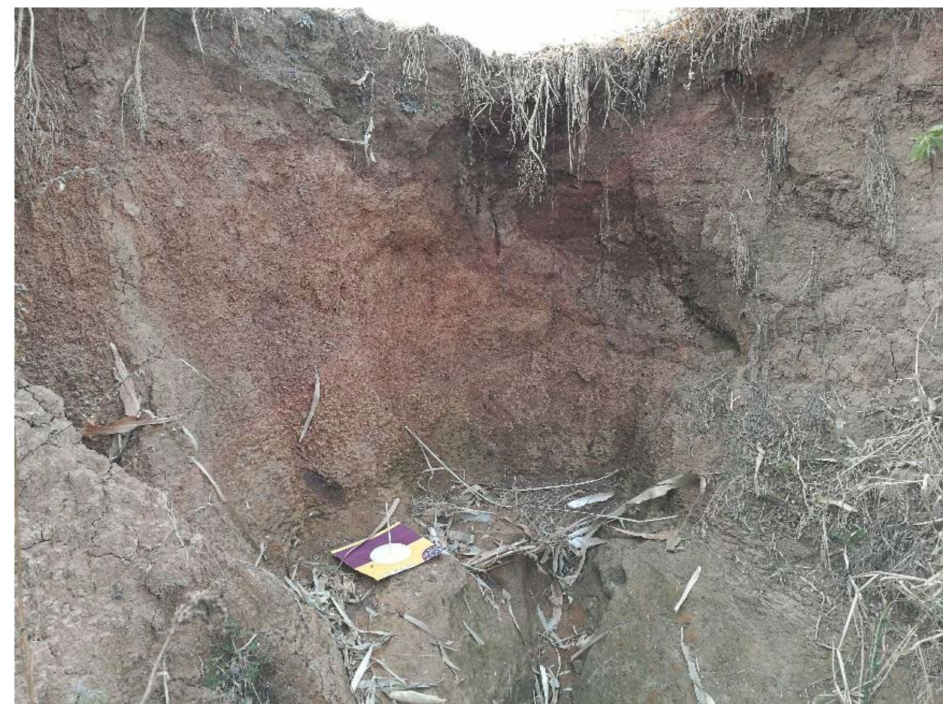
Figure 18. Picture of the gully head acquired in October